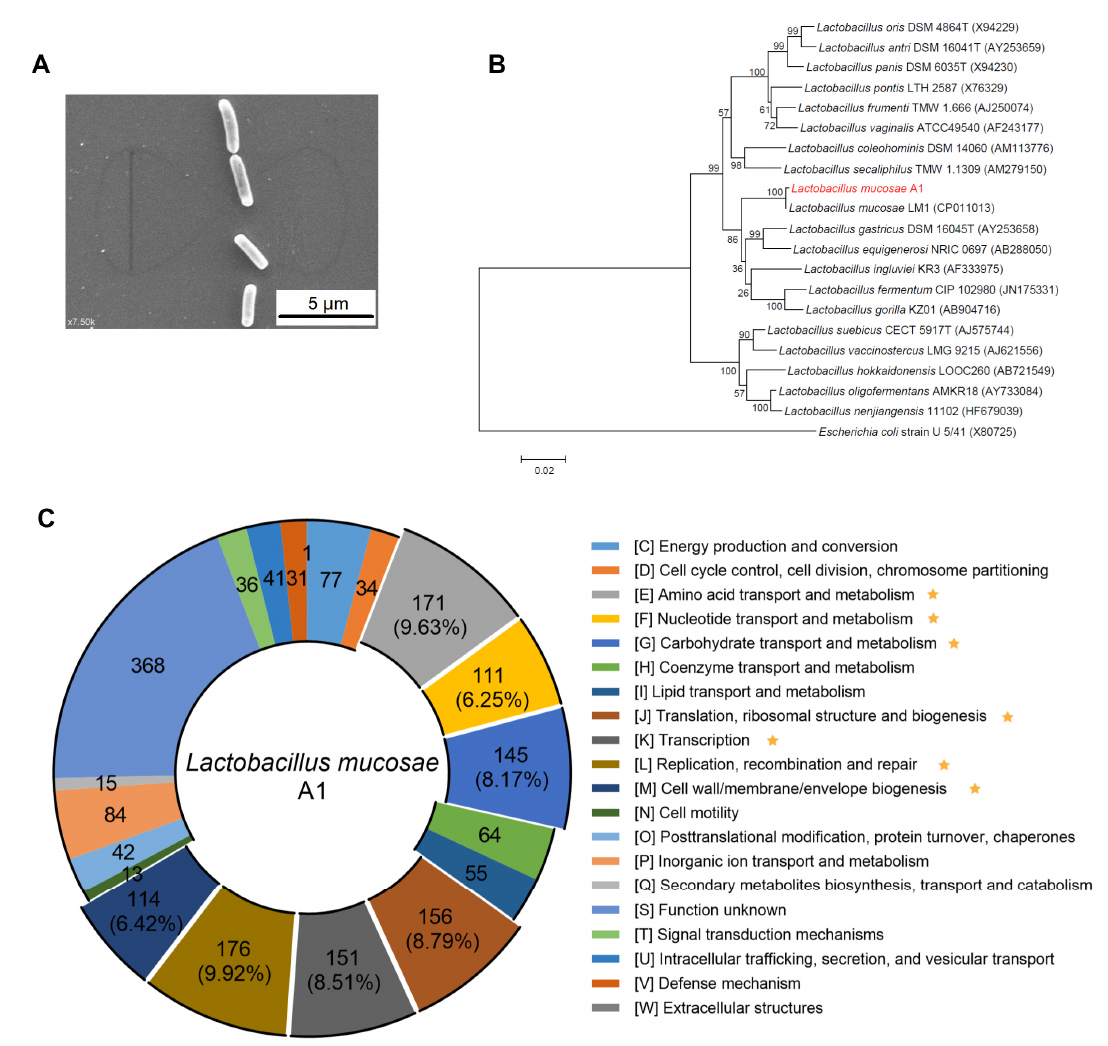
Figure 1. Identification and genomic characterization of L. mucosae A1. ( A ) Electron micrograph of A1 strain. The scale bar is 5 µ m. ( B ) Phylogenetic relationships of the A1 strain with its relatives based on 16S rRNA gene sequences. The nearest neighbor of A1 strain was L. mucosae LM1. Escherichia coli U5 / 41 was used as an outgroup. The tree was constructed using the Neighbor-Joining method in MEGA6. The bar indicates sequence divergence. ( C ) Functional categories in the clusters of orthologous groups (COG) analysis of L. mucosae A1. The numbers out the brackets on the circle represents the numbers of genes in each COG category. The numbers in the brackets are the percentages of genes in the corresponding categories to the total genes identified by COG database. Those COGs have more than 5% of the total genes are marked with an